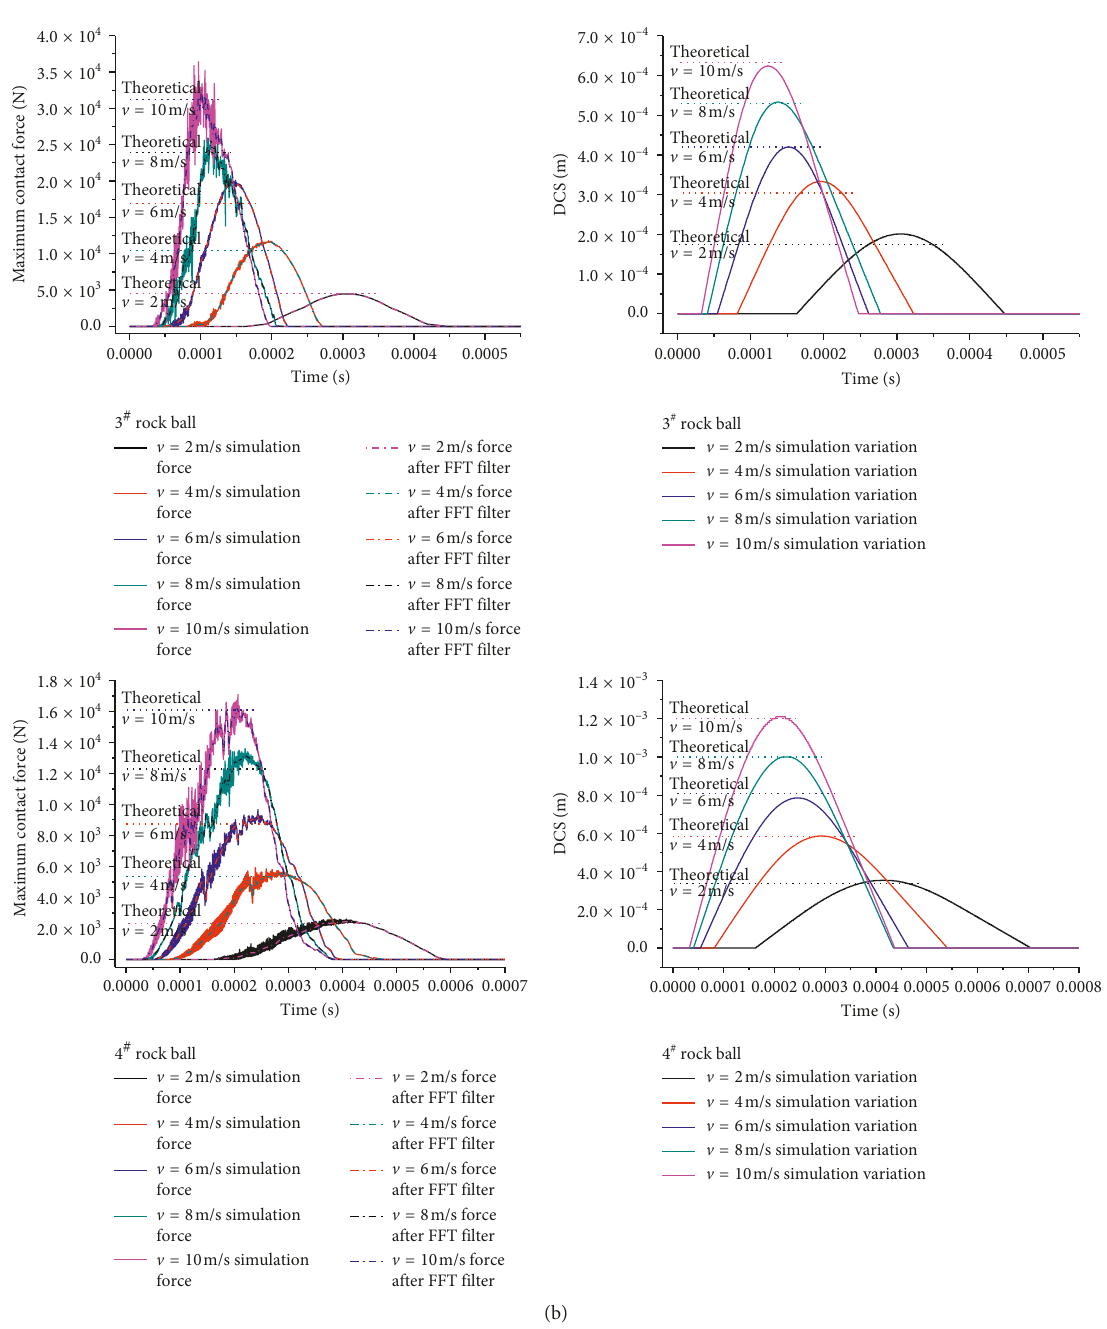
Figure 10: Force-time and